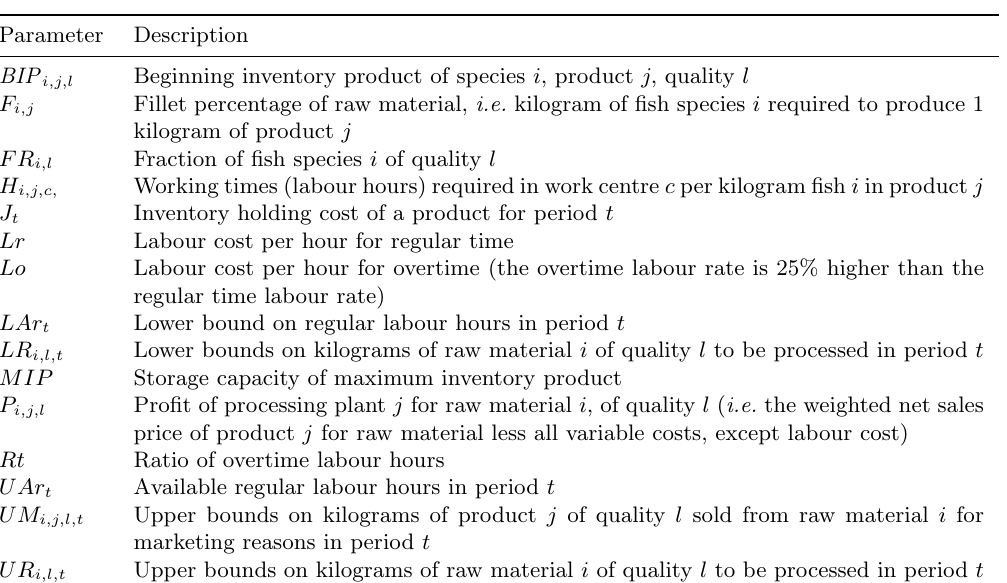
Table 3: Processing